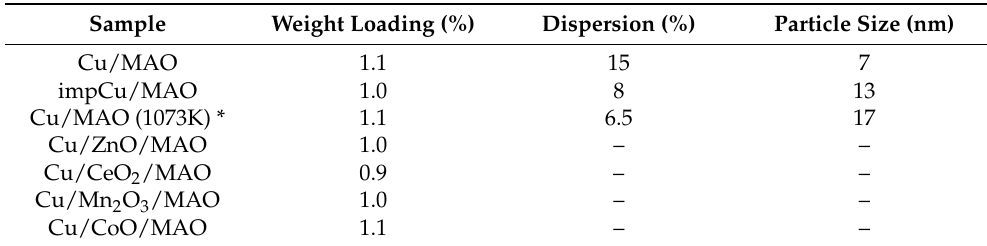
Table 2. Weight loadings, dispersions, and equivalent particle sizes of various samples.